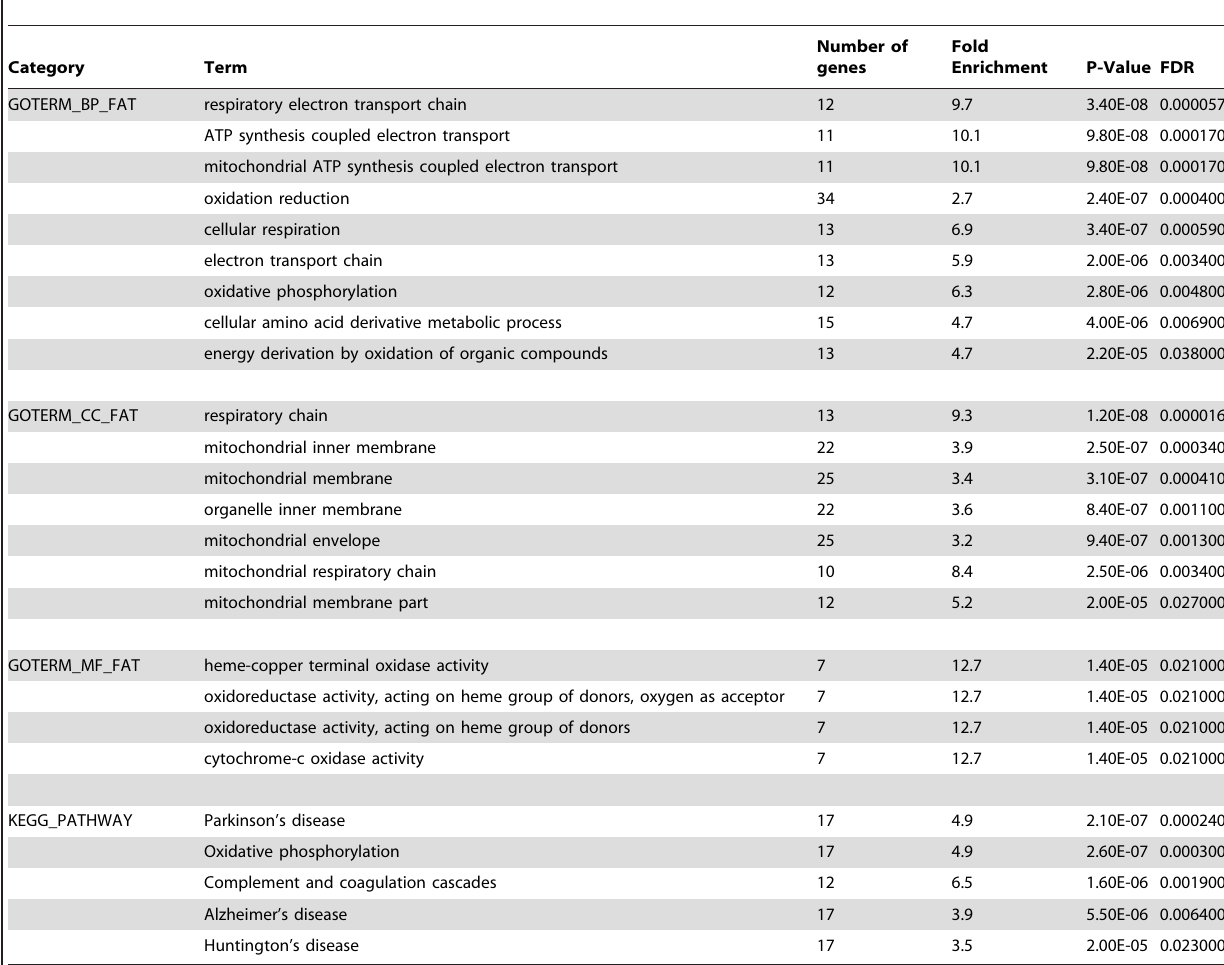
Table 1. The most overrepresented biological annotations from the list of genes differentially expressed as a result of maternal exposure to predation